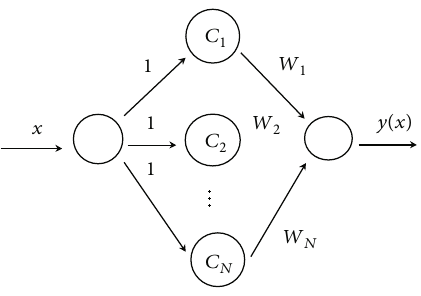
Figure 1: Triangle neural network